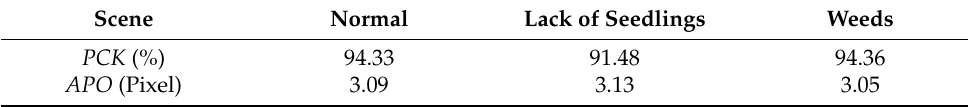
Table 5. Comparison of network prediction results in the three